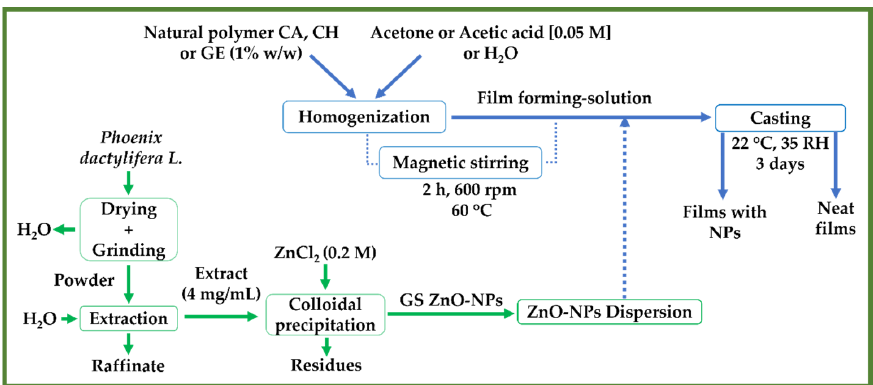
Figure 1. A flowchart depicting the preparation of ZnO ‐ NPs utilizing an aqueous extract from Phoenix dactylifera L. and the processing of the different neat films and films reinforced with ZnO ‐ NPs (1.0% w / w ) (CA ‐ based, CH ‐ based, and GE ‐ based film ZnO ‐ NPs).